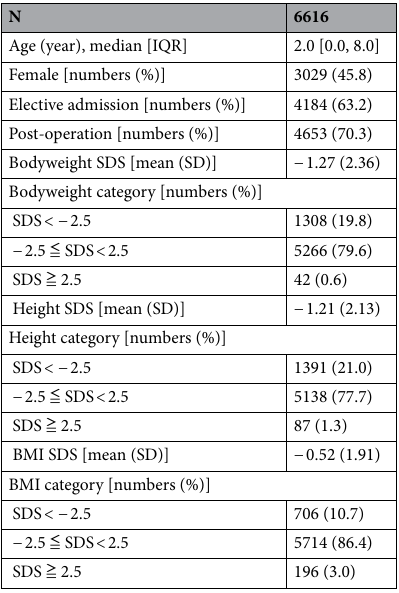
Table 1. Characteristics of study population. BMI, body mass index; IQR, interquartile range; SD(S), standard deviation (score). Patients with SDS < − 2.5 were classified into the “extremely low” category for each